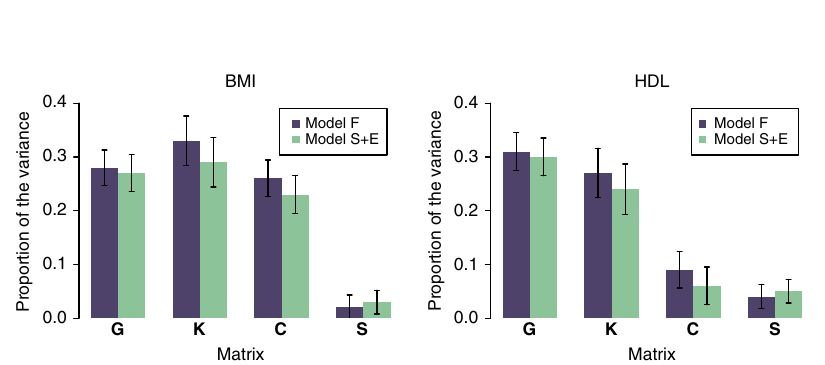
Fig. 3 Heritability estimates from models with different covariates. Proportion of the variance in two different traits captured by each of the genetic or environmental matrices fi tted: Model F: including four matrices and sex, age, clinic as covariates ( blue bars ); Model S+E: including four matrices, gPCs, SELS and sex, age, clinic as covariates ( green bars ). Error bars show the standard errors of the